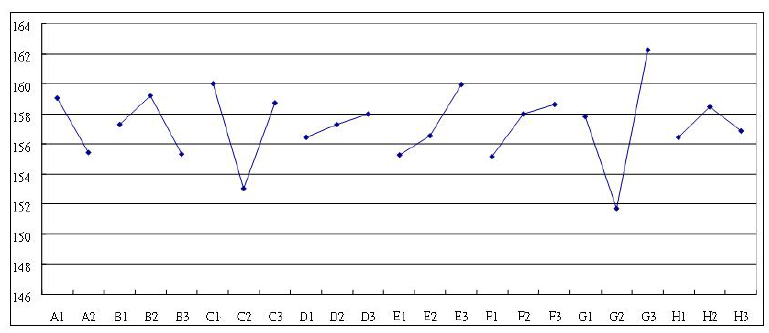
Figure 7. The S/N cause effects graph of control factors.